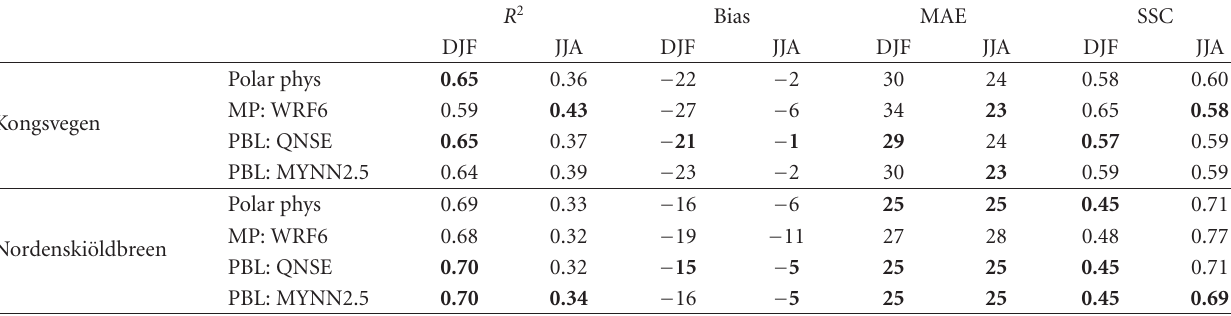
Table 12: Long-wave radiation in 2.7 km resolution. Bold numbers indicate the best result for each AWS. Vestfonna data are not used here because of the lack of data during the chosen period.